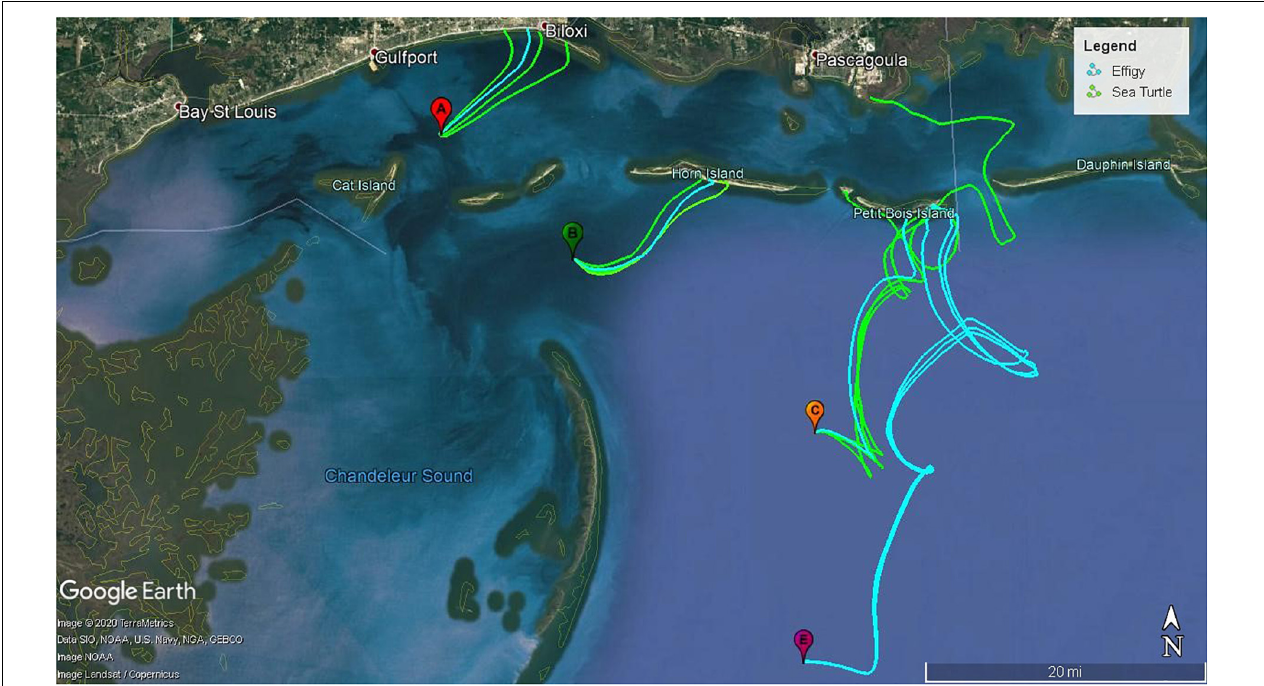
FIGURE 7 | Carcass (green) and effigy (blue) drift tacks from sites A, B, C and E deployed on 25 April 2017. All objects beached on or before 29 April 2017.